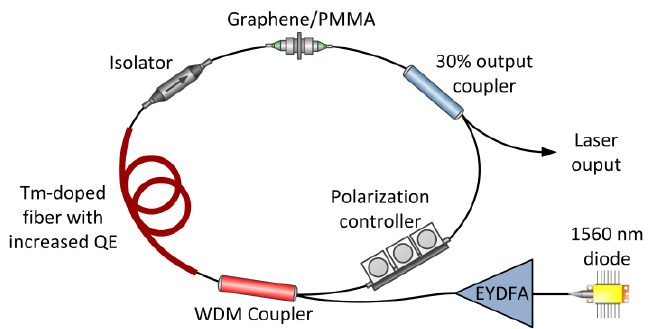
Figure 2. The setup of a Tm-doped, mode-locked fiber laser based on graphene saturable absorber.